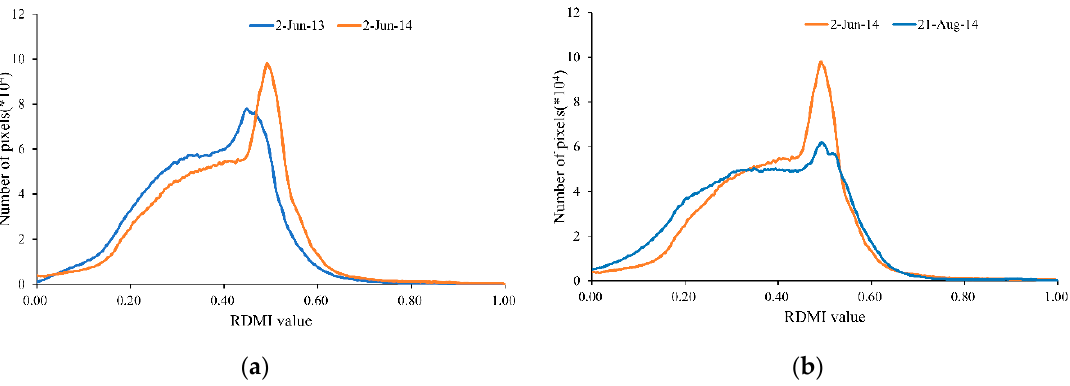
Figure 16. A comparison of the RDMI frequency distribution on different dates. ( a ) A comparison between 2 June, 2013 and 2 June, 2014; and ( b ) a comparison between 2 June, 2014 and 21 August, between 2 June 2013 and 2 June 2014; and ( b ) a comparison between 2 June 2014 and 21 August 2014.